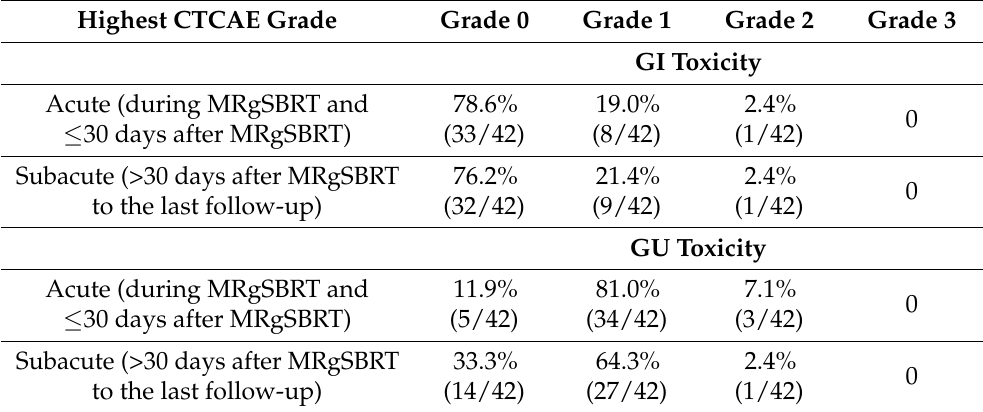
Table 2. The cumulative incidence of clinician reported gastrointestinal (GI) and genitourinary (GU) toxicities according to Common Terminology Criteria for Adverse Events (CTCAE) 5.0 in the patients ( N =